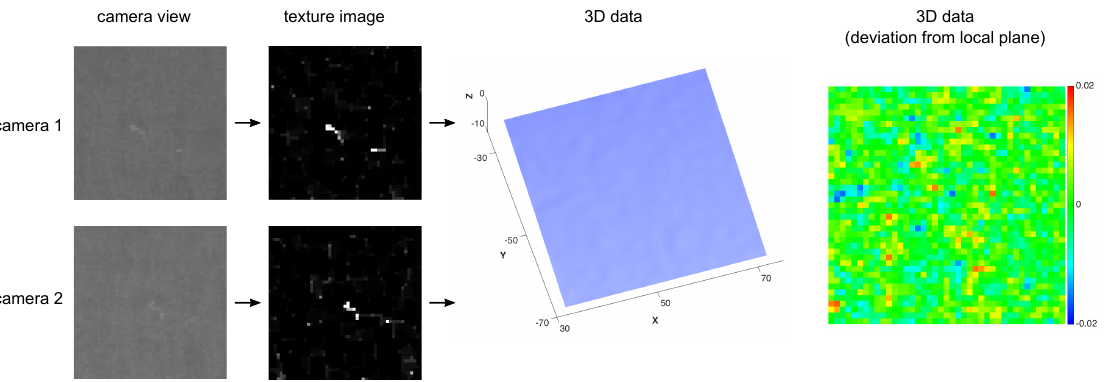
Figure 7. Segment around a keypoint used for blockmatching, given as camera view and texture image for the stereo pair, and corresponding 3D data. For better visibility, deviation of 3D data from a locally fitted plane is given color-coded (scale: +/- 20